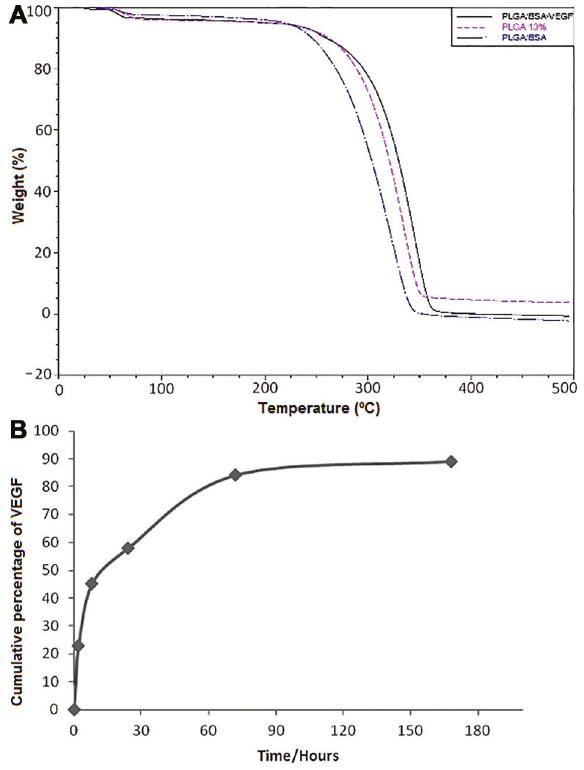
Figure 4. A , Graph obtained by thermogravimetric analysis showing the mean percentage of weight loss of the PLGA/BSA/ VEGF, PLGA/BSA and PLGA 13% scaffolds. B , In vitro VEGF liberation curve from the PLGA/BSA/VEGF scaffolds. PLGA: polylactic-co-glycolic acid; BSA: bovine serum albumin; VEGF: vascular endothelial growth factor.